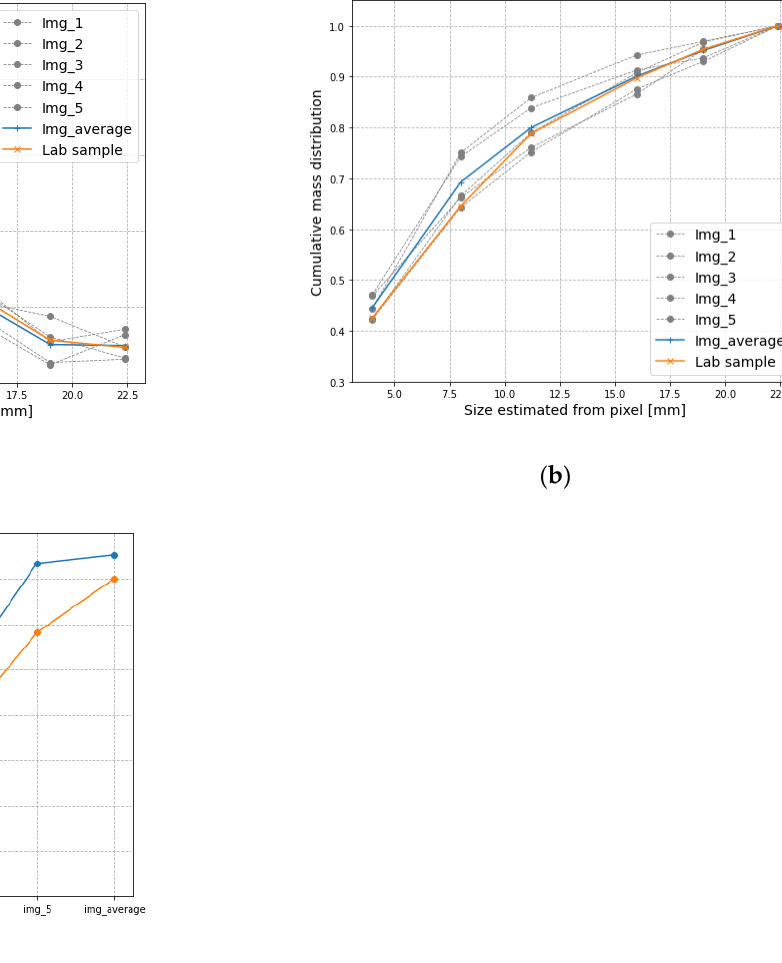
( b ) cumulative size distribution; ( c ) RSME of the estimated